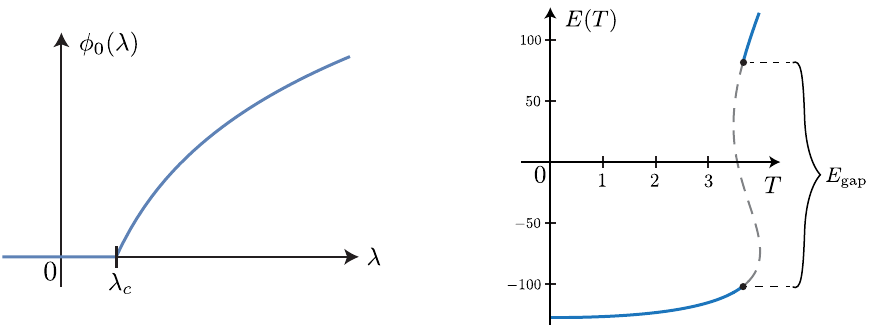
Figure 3. The left diagram shows the phase transition at λ = λ c in equation (3.7), where we plot φ h = φ 0 ( λ ) obtained by numerically solving W ( φ 0 ) = 0 . In the right diagram is plotted the black hole energy as a function of the temperature for λ = − 40 , taking into account the phase transition (left diagram in figure 2). We observe a gap in the spectrum generated by the phase transition at λ below λ 0 in c